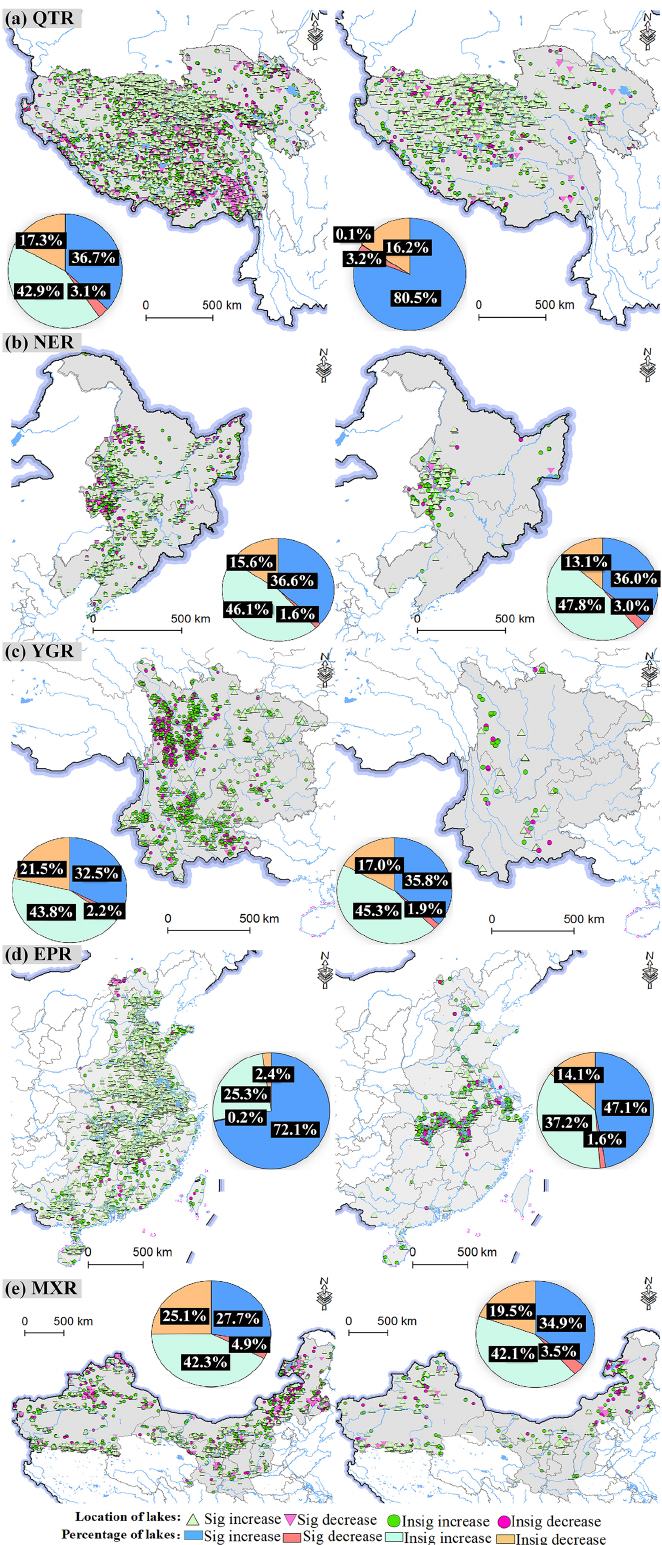
Figure 11. The spatiotemporal patterns of SD in lakes in the five limnetic regions from 1985 to 2020 (from left to right are the spatiotemporal patterns of lakes with an area ≤ 1km 2 and the spatiotemporal patterns of lakes with an area > 1km 2 ). Note: Sig., significant and Insig.,